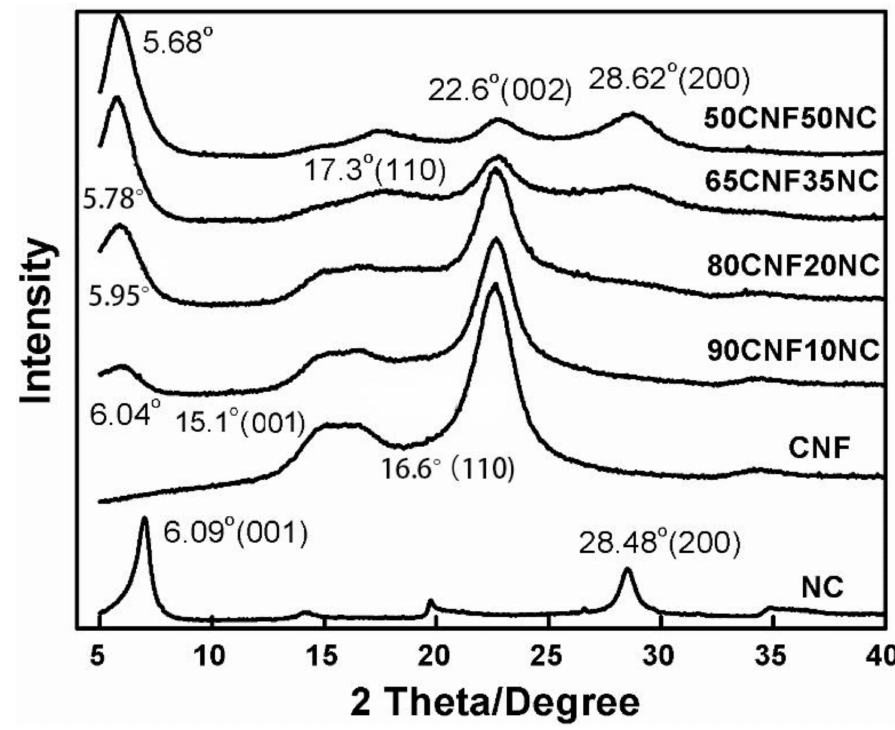
Figure 4. X-ray di ff raction (XRD) patterns of pure NC and CNF as well as of the CNF / NC composites.